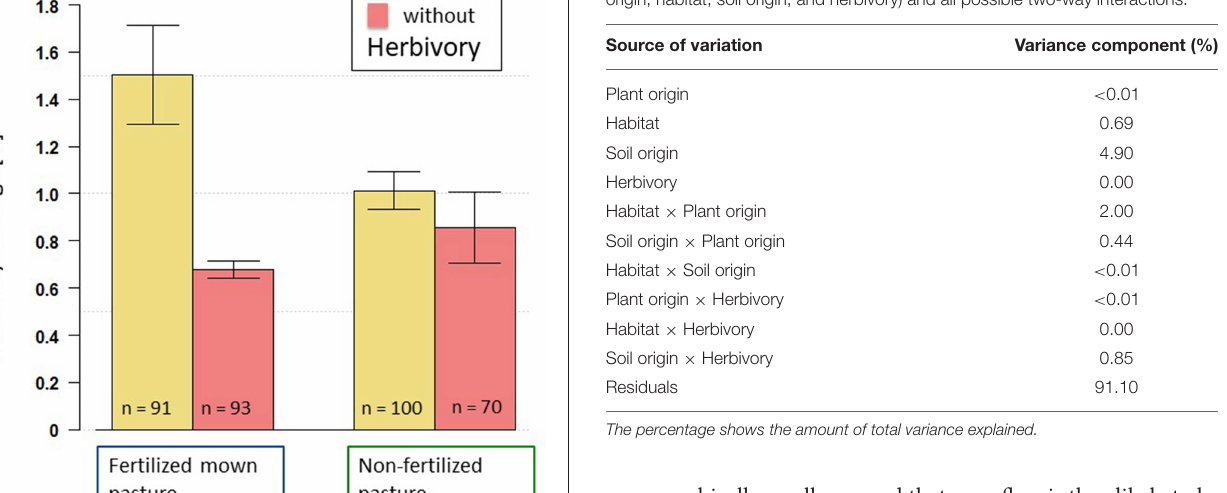
TABLE 3 | Results of a variance component analysis for total plant biomass using a linear mixed-effects model, testing all factors included in our study design (plant origin, habitat, soil origin, and herbivory) and all possible two-way